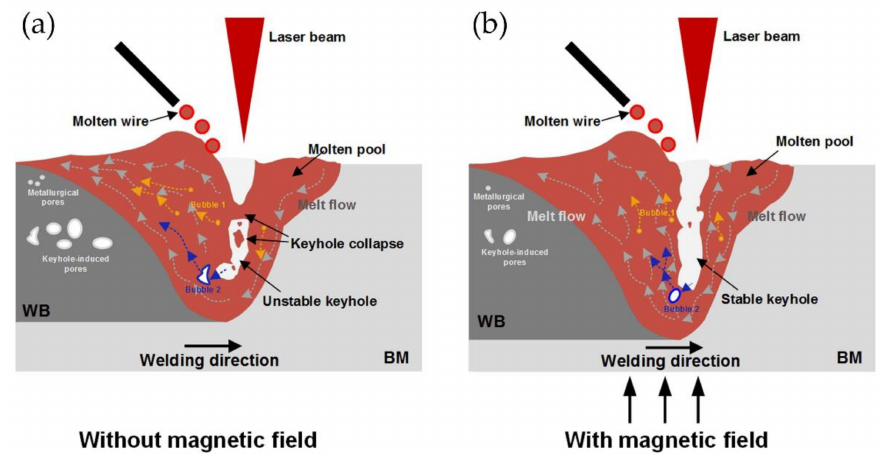
Figure 11. Microhardness of joints welded by hybrid laser–MIG welding [95].